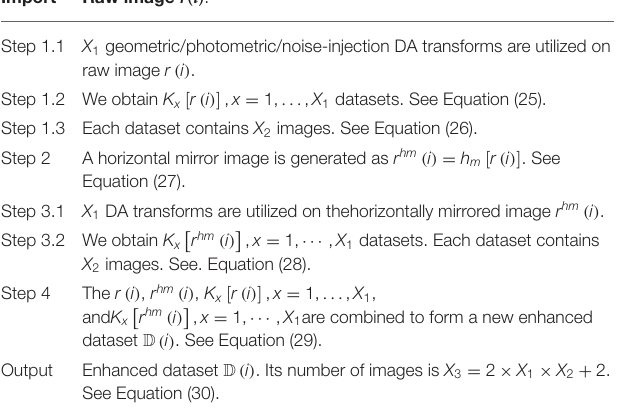
TABLE 4 | Pseudocode of 18-way DA. Import